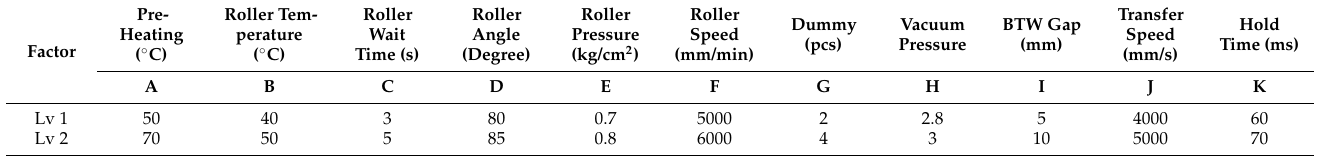
Figure 10. Operations in the soft-to-hard lamination stage. Table 2. Control factors and their corresponding levels for the L 12 (2 11 ) experiment.